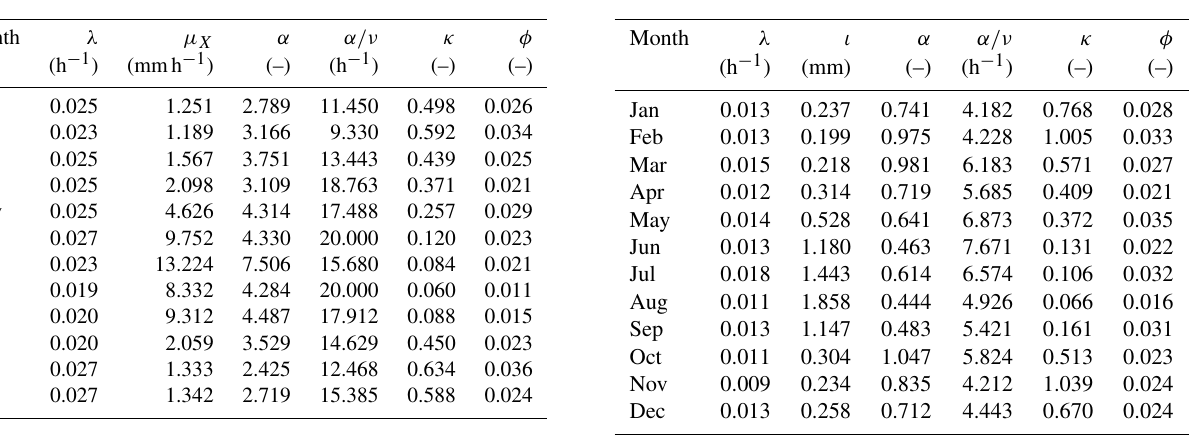
Table 4. Parameters for the RBL2-sM-NC model using Bochum gauge data; constraint: α >